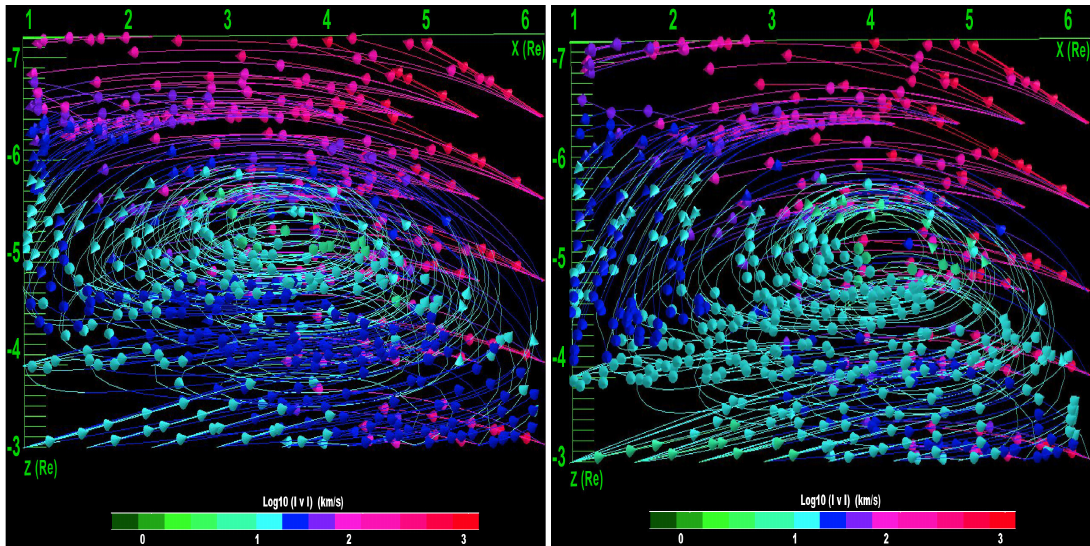
Fig. 18. Vortex developed at the dawn dayside with the rotation axis closely aligned to the y axis (left). The same vortex can be encountered after 1h and 16min of simulation (right). This vortex has nearly a fixed position for more than an hour, but it actually moves closer to the magnetopause boundary in the sunward